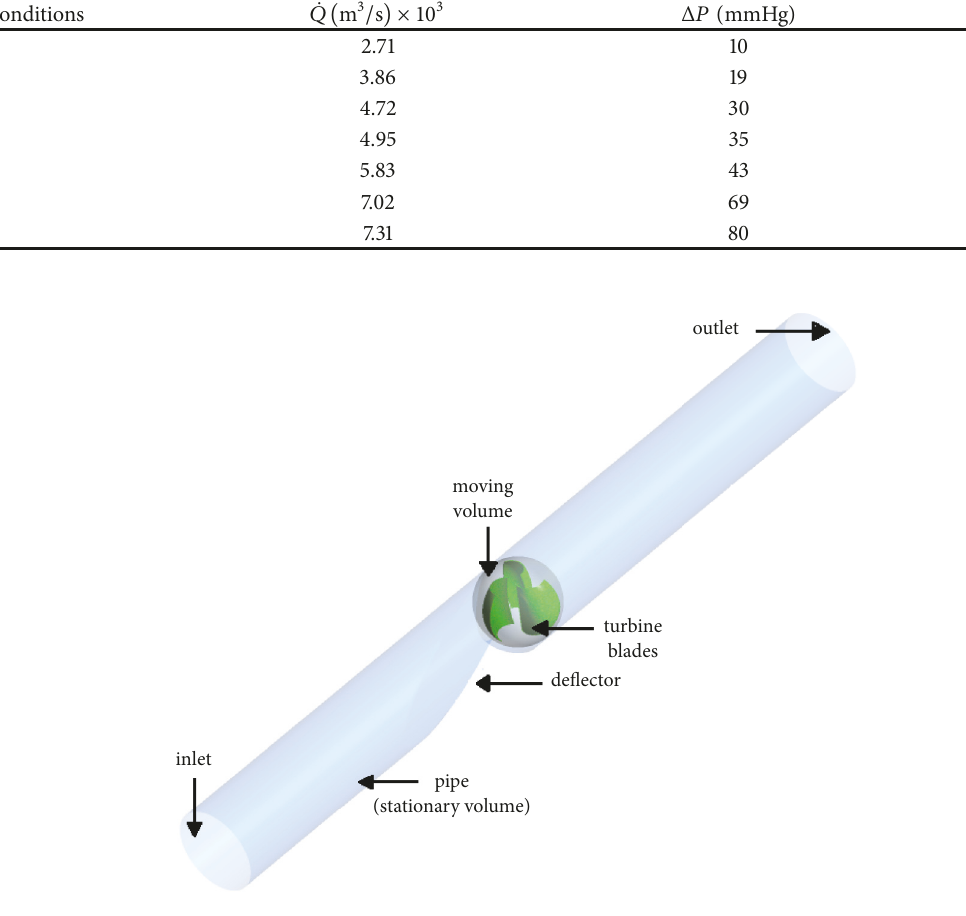
Figure 5: Numerical flow field domain